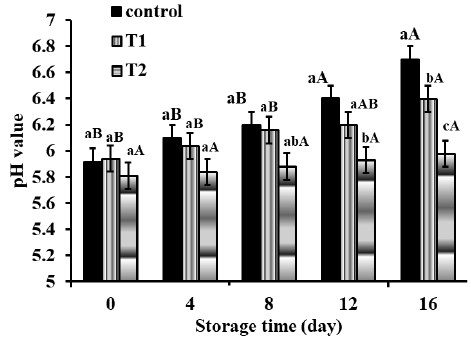
Figure 3. Changes in pH value in meatball samples with incorporated cod liver oil microcapsules during storage at 4 ± 1 °C. Error bars represent standard deviation (n = 3). T1: free cod liver oil direct addition, T2: encapsulated cod liver oil. Different superscripts of (a – c) lowercase letters indi- cate significant differences at p < 0.05 between treatments at each storage time. Different superscripts of (A, B) uppercase letters indicate significant differences at p < 0.05 of each sample over the storage period.